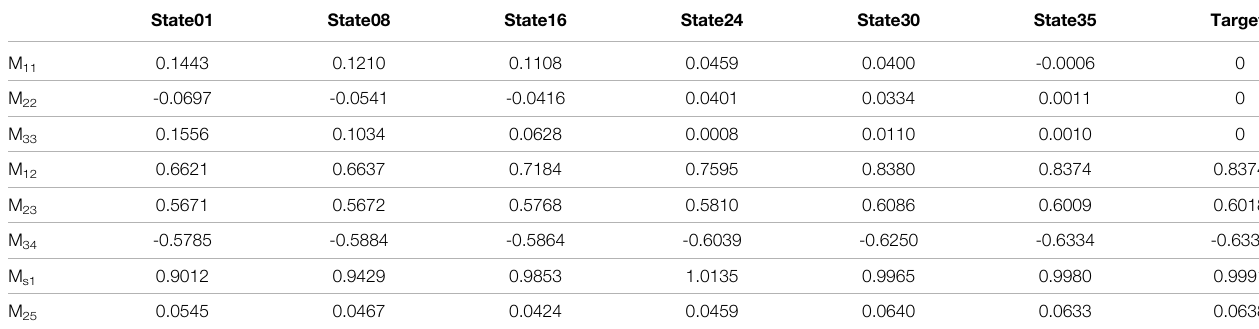
TABLE 3 | Coupling values for some intermediate tuning